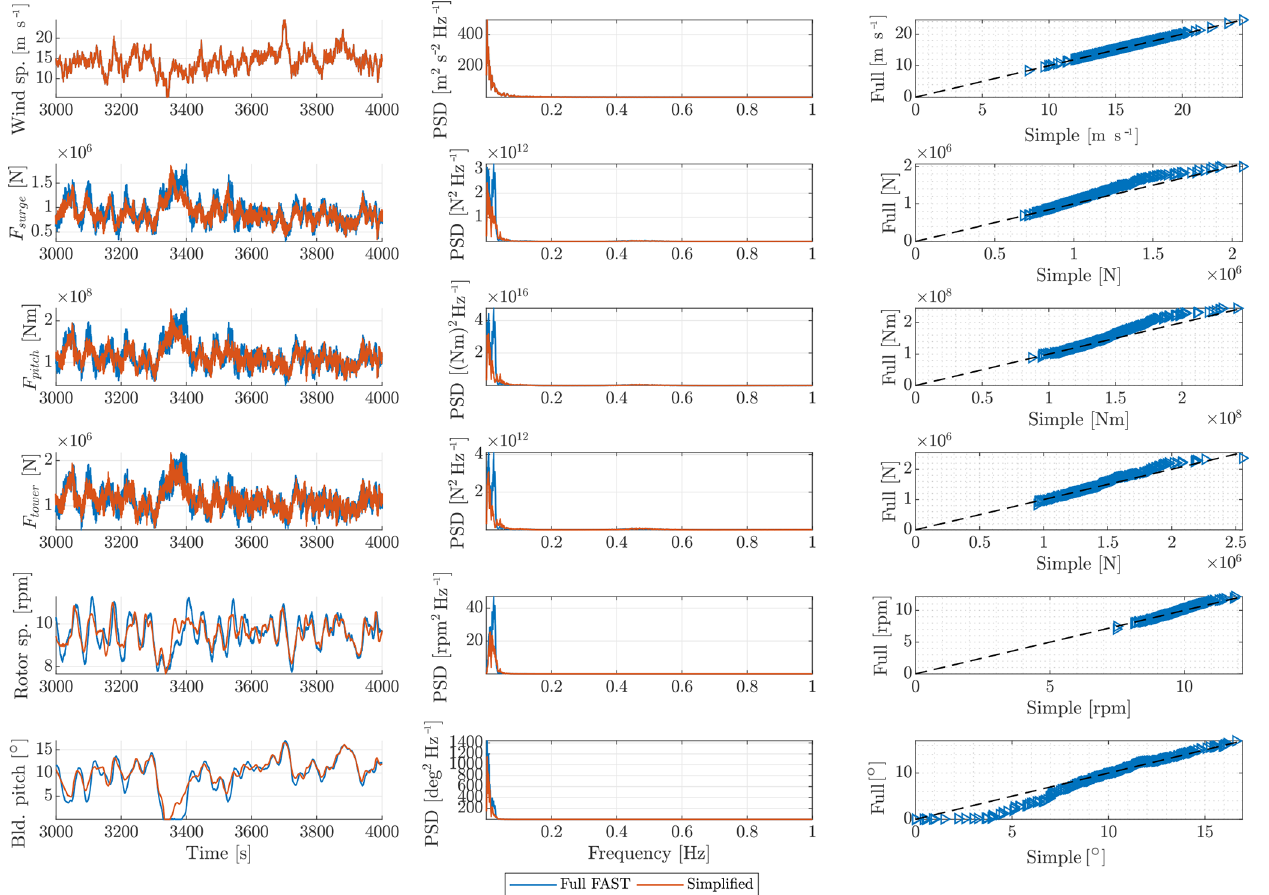
Figure 14. Extracted aerodynamic forcing applied in the surge, pitch and tower deflection degrees of freedom and turbine operational data for DLC 1.3 with 13 . 9ms − 1 mean wind speed. Left: time series outline. Middle: corresponding power density spectrum (PDF). Right: peak values (sorted) for the full FAST computations as a function of the corresponding maximum values in the simplified method.